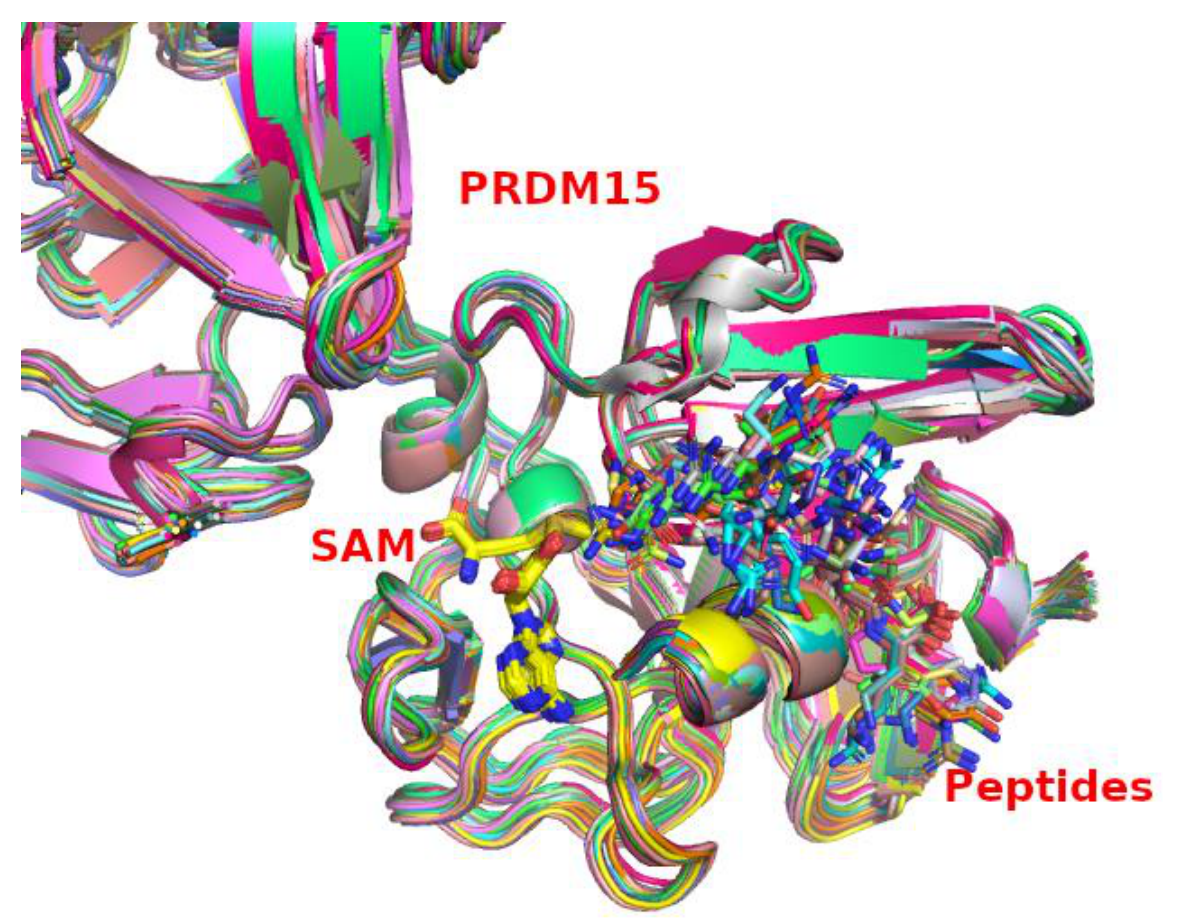
Figure 4. Superimposition of the modeled PRDM15 complex with 64 different peptides and SAM.